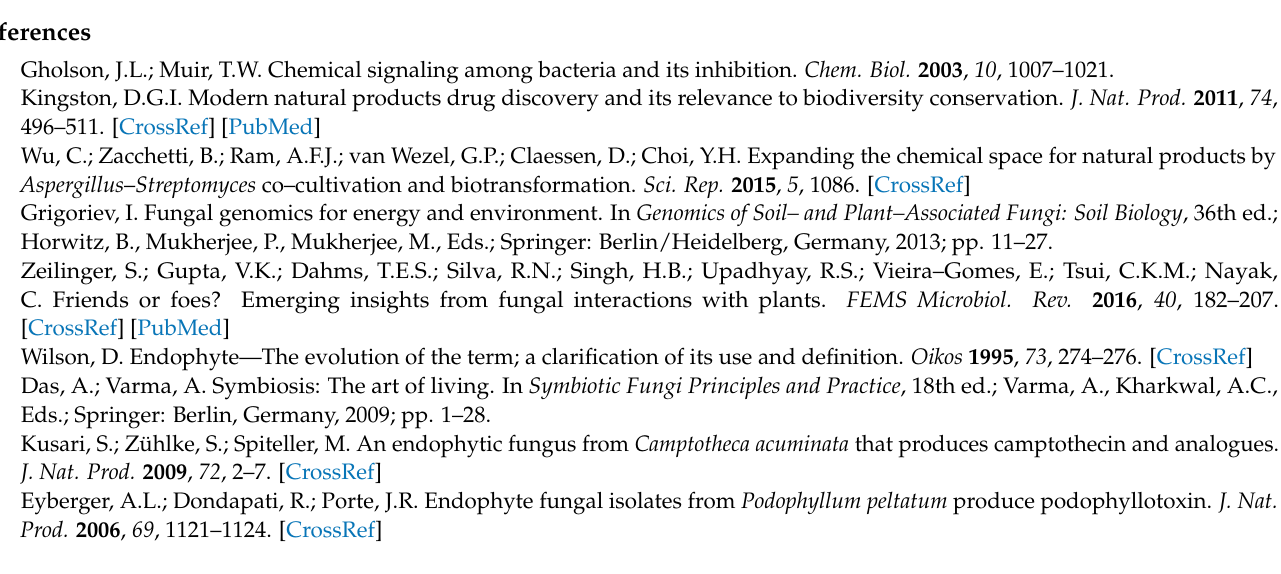
Table S1: Accession numbers and supplementary isolated strain